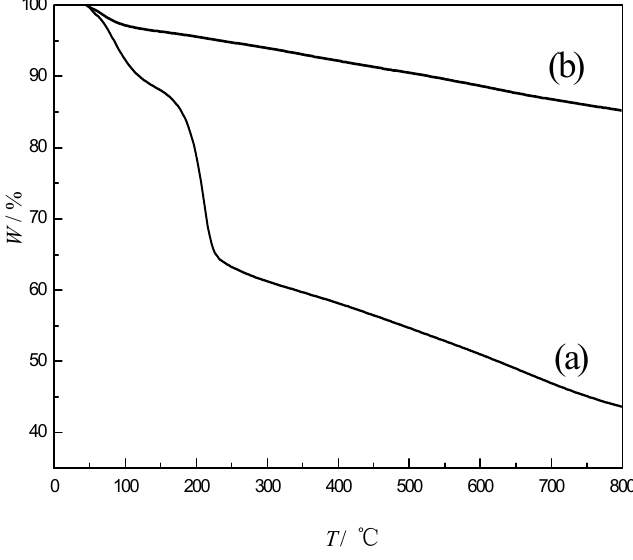
Figure 7. Thermogravimetric curves of (a) GO and (b) GS1.